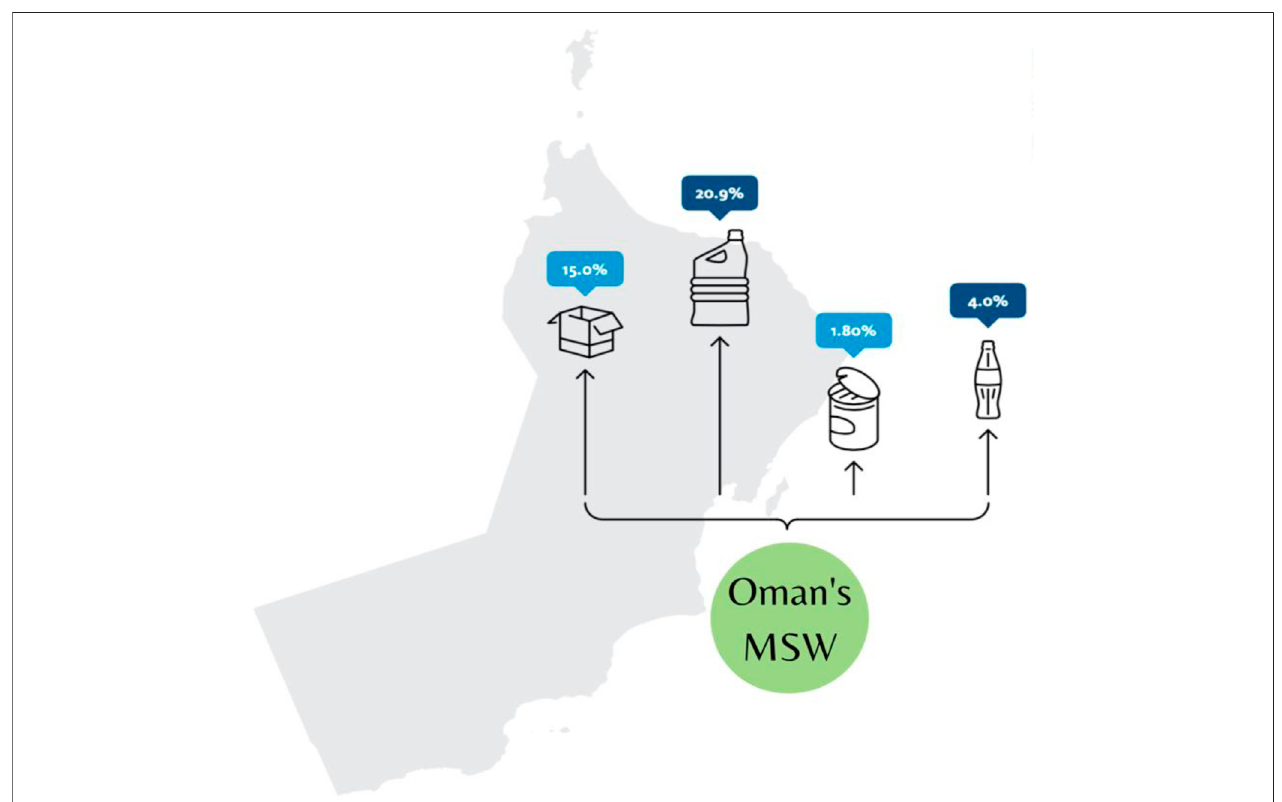
FIGURE 3 | Percentages of recyclables in